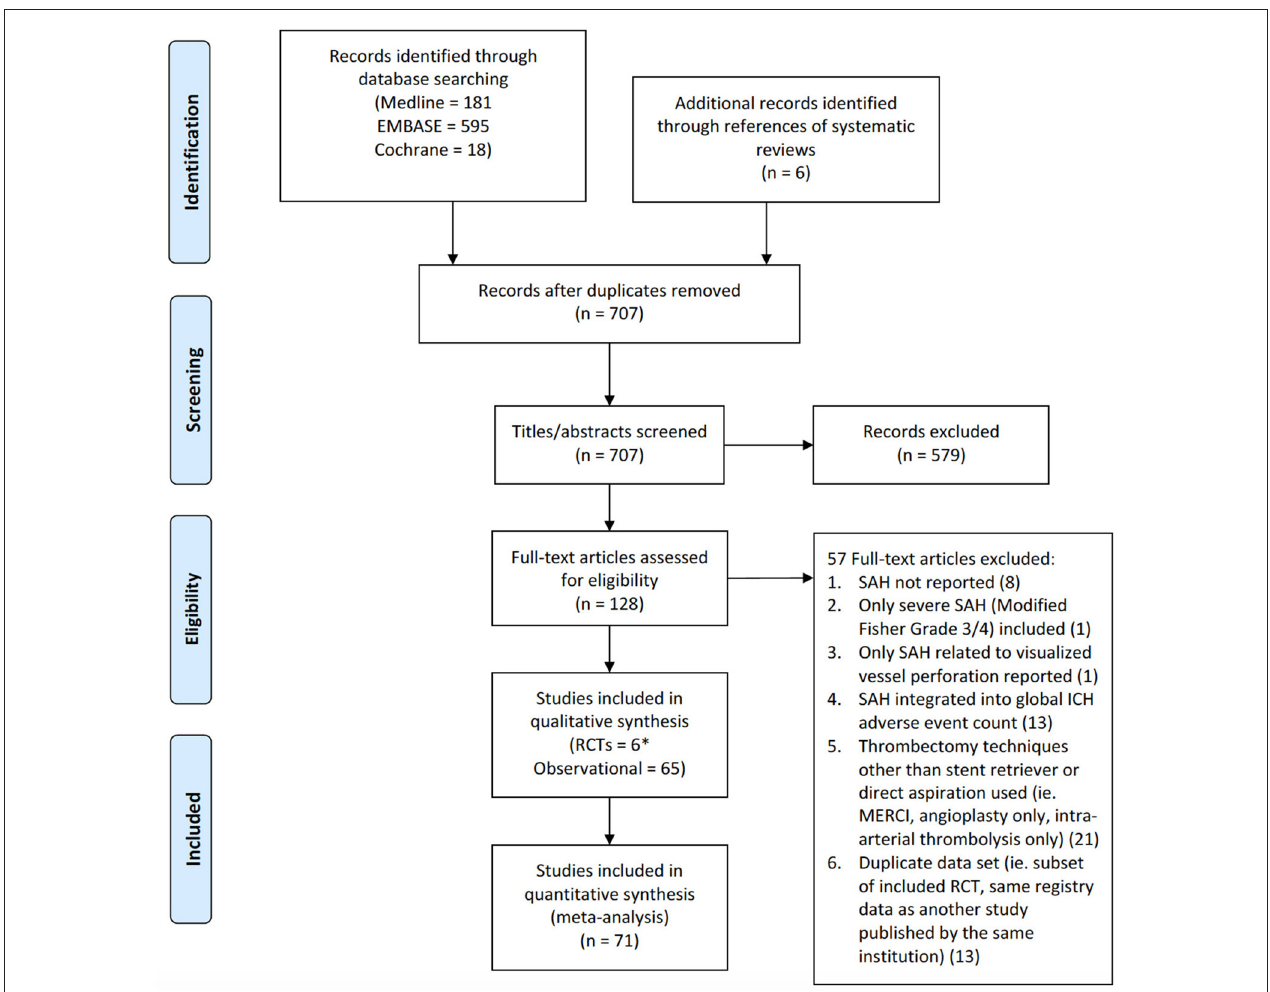
FIGURE 1 | PRISMA flow diagram of study identification and selection. *For the RCT by Saver et al.—SWIFT, only one treatment arm (Solitaire stent retriever) was used.